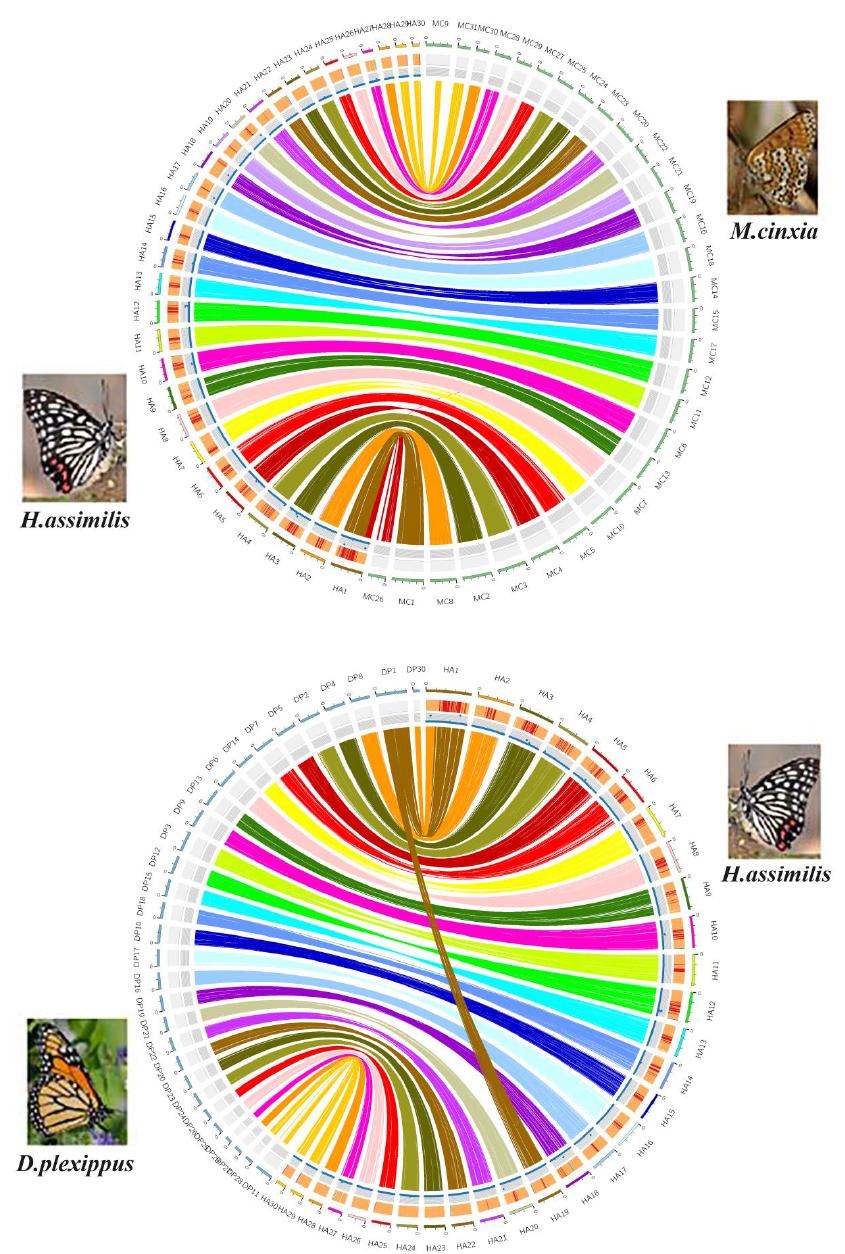
Figure 1. Synteny alignment of the genome of H. assimilis (male), M. cinxia (male), and D. plexippus (male). The tagged HA01 to HA30 refer to the chromosomes of the sequenced H. assimilis , the